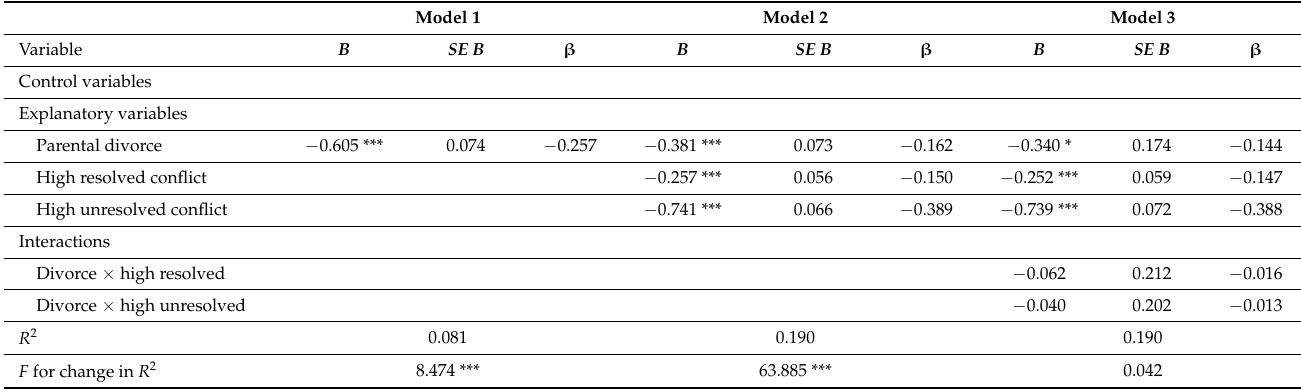
Table 6. Summary of the hierarchical multiple regressions for the variables predicting trust in father-child